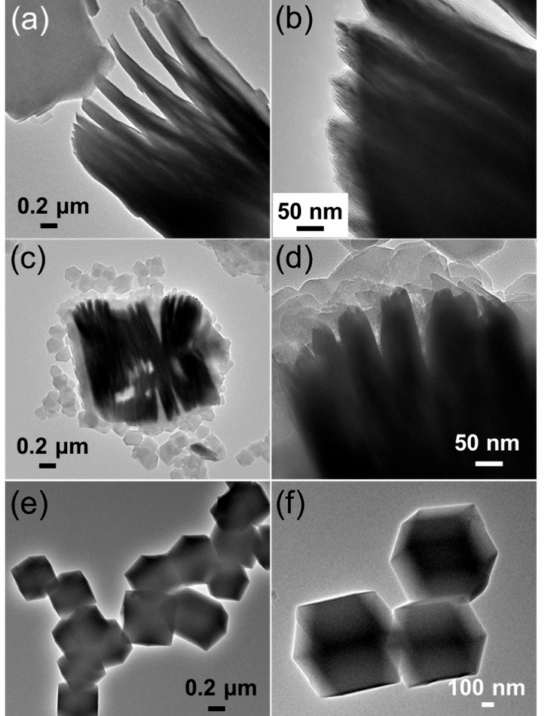
Figure 3. Transmission electron microscopy (TEM) images of ( a , b ) Ti 3 C 2 T x , ( c , d ) CoNi-ZIF-67@Ti 3 C 2 T x , and ( e , f ) pure CoNi-ZIF-67 at di ff erent